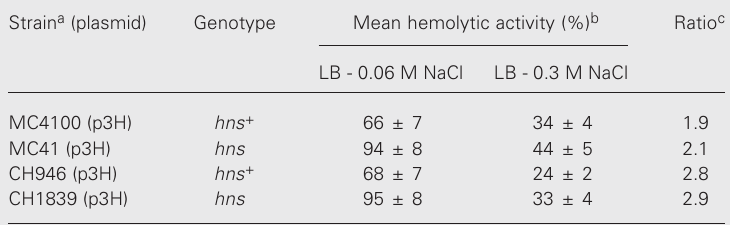
Table 2. Effect of osmolarity on the hemolytic activity of Escherichia coli strains transformed with plasmids carrying the cloned Serratia marcescens shlA gene. Strain a